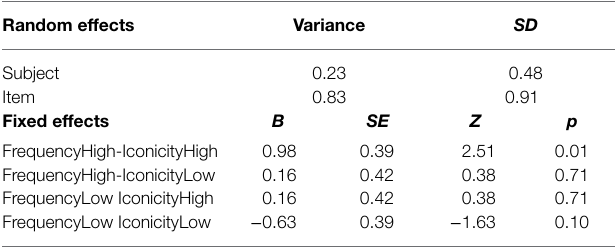
TABLE 7 | Model output for accuracy by chance by frequency and